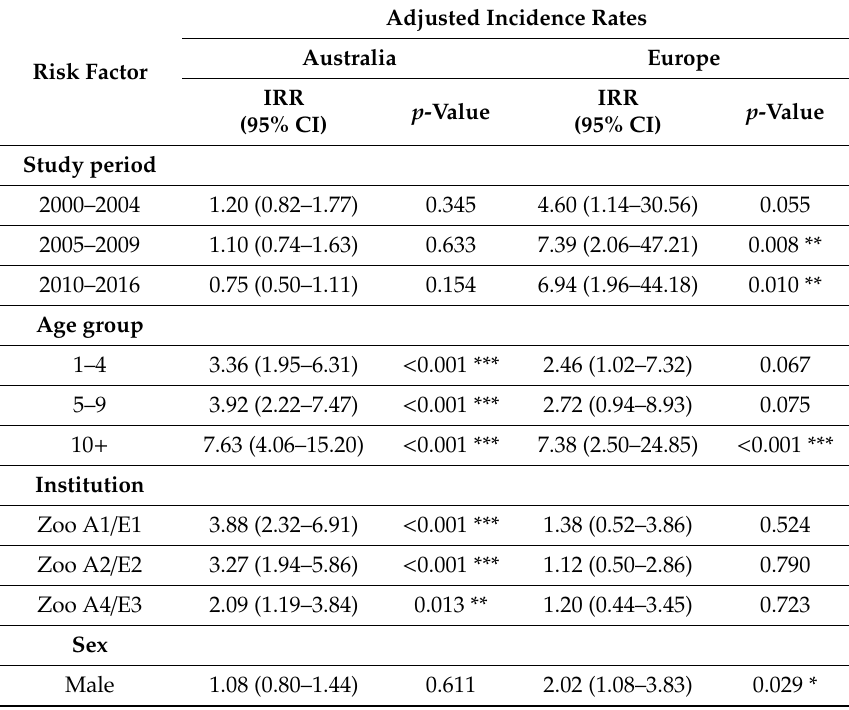
Table 3. Adjusted incidence rate ratios (IRR) for MPPD risk for macropods housed at eight zoological institutions across Australia and Europe between 1 January 1995 and 28 November